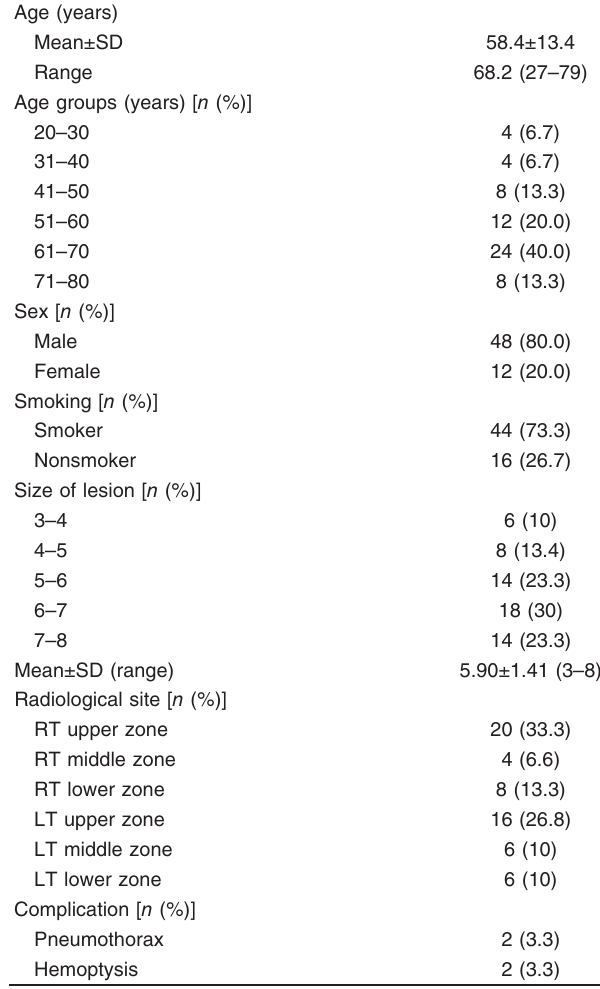
Table 1 Sociodemographic characteristics among patients, size, and location of the lesion and complication ( N = 60)